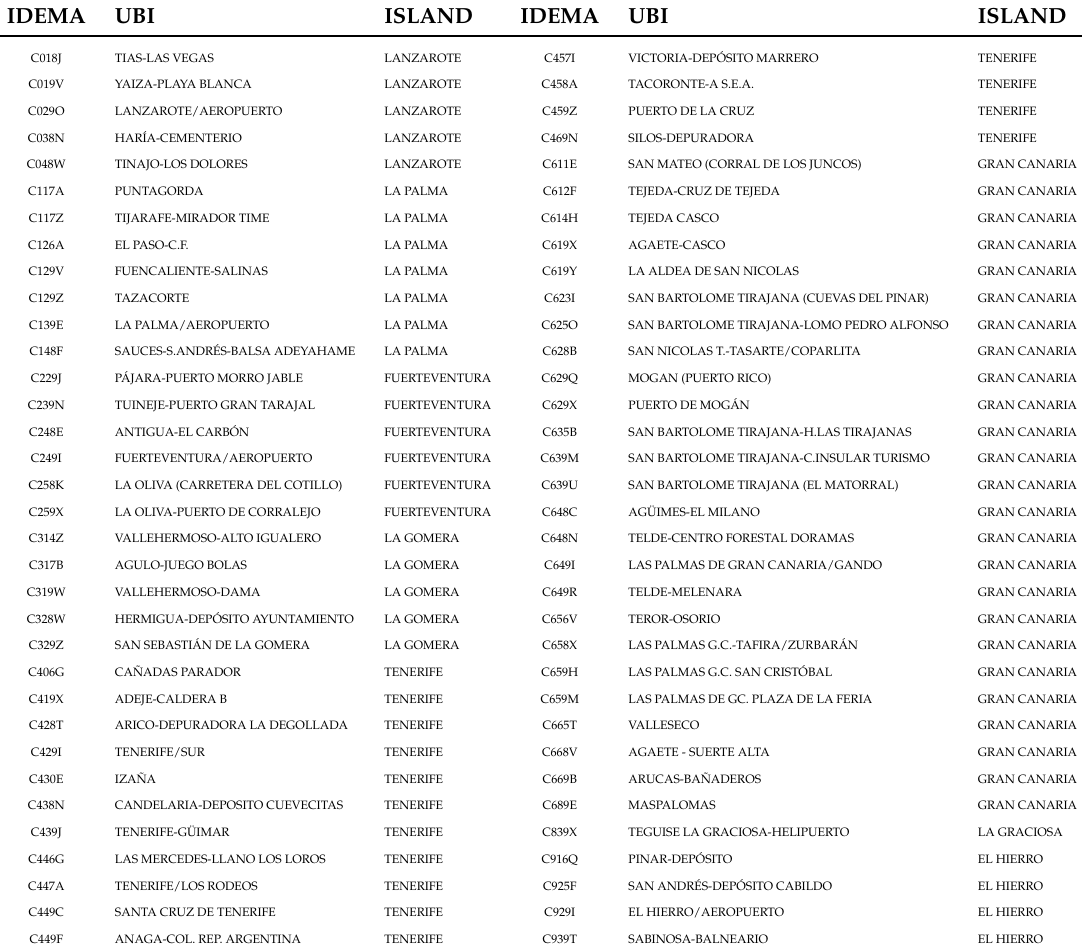
Table 1. AEMET Weather Stations in the Canary Islands (ID code (IDEMA), location, and island).